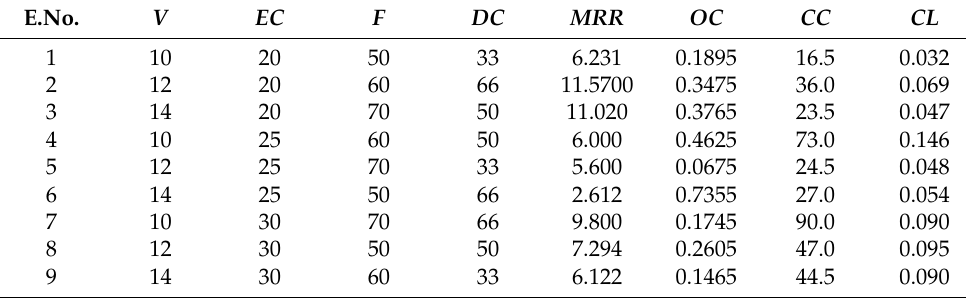
Table 4. Details of experiments—parameters and responses—quenched.